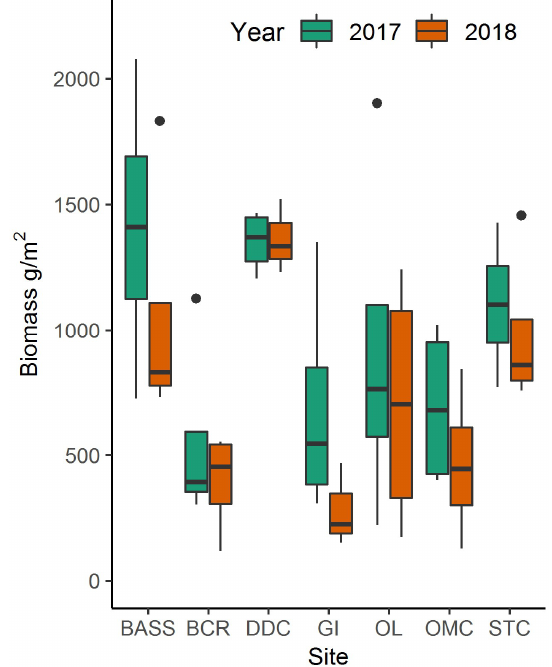
Figure 4. Whisker and box plot of field-collected biomass samples within North Inlet. Top and bottom of the boxes indicate the third and first quartile, respectively. Horizontal line within the box indicates the median value and the whiskers indicate the maximum and minimum.